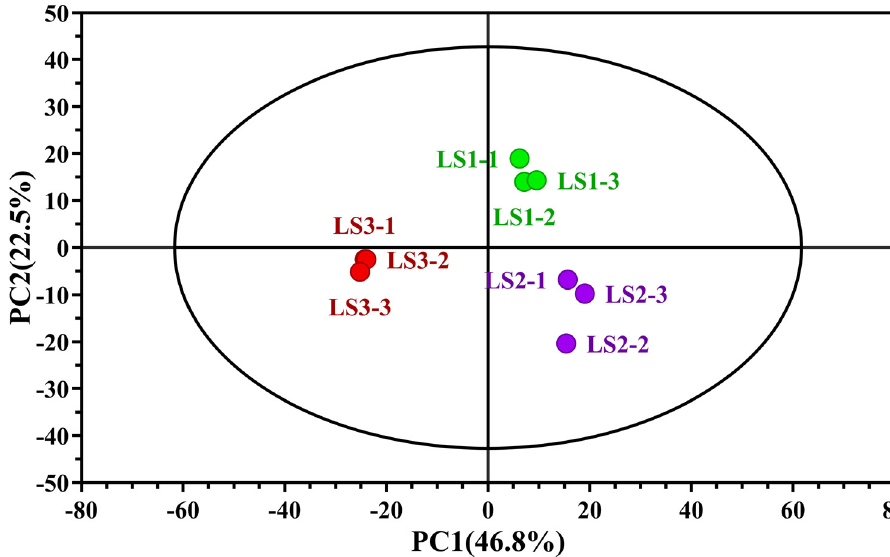
Figure 3: Principal components of metabolites in jujube leaves at di ff erent foliar